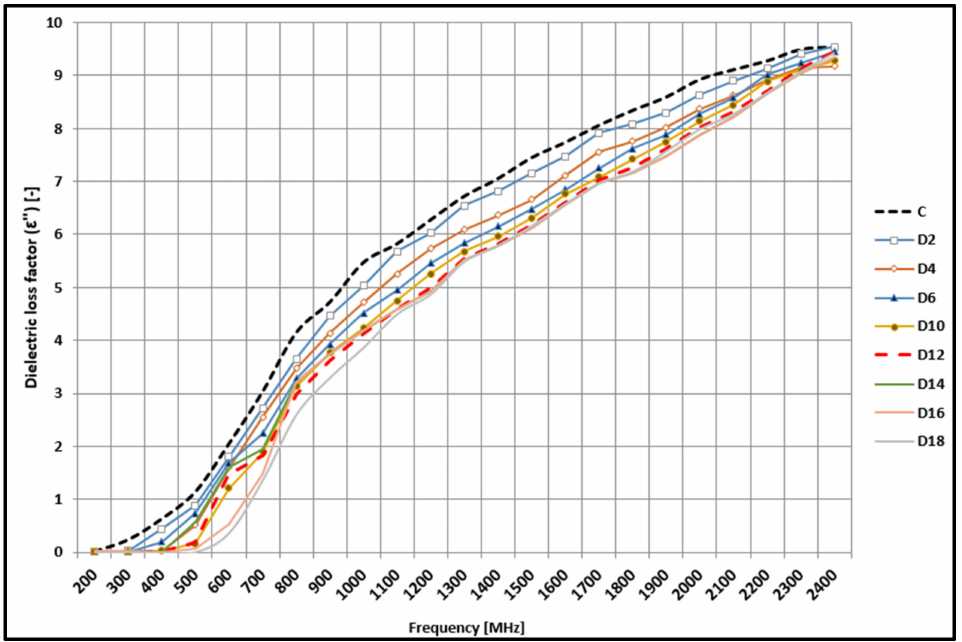
Figure 10. Trends of the dielectric loss factor during the fermentation of the control (non-treated) samples.